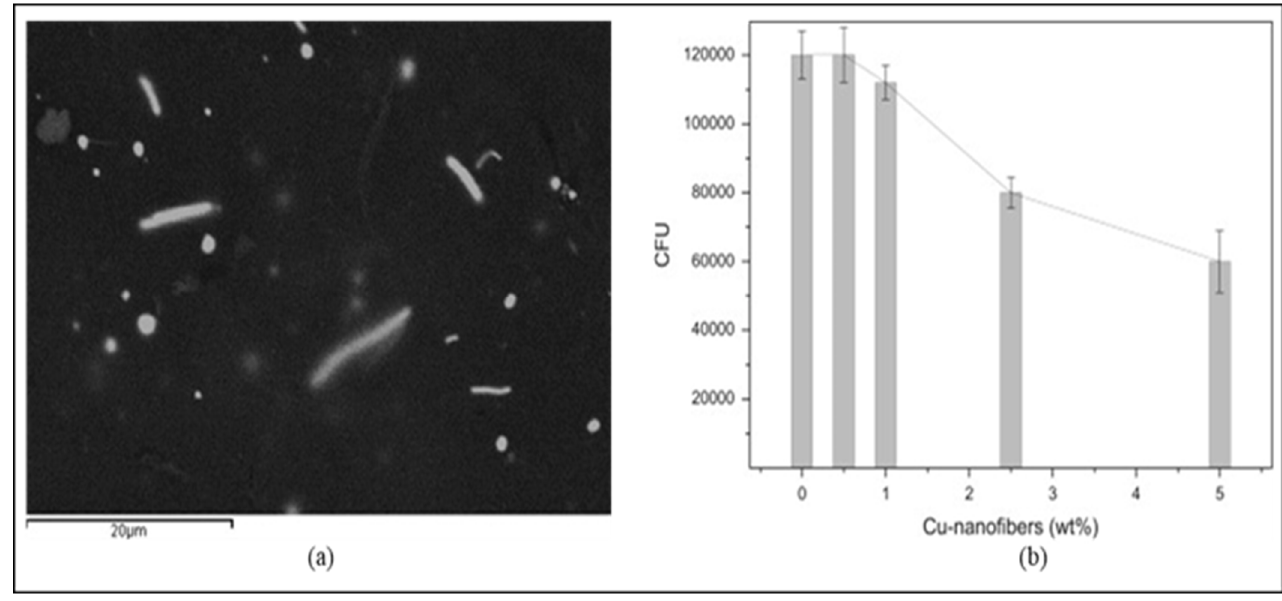
Figure 7. ( a ) SEM images of HDPE/Cu-nanofiber nanocomposites containing 2.5 wt % Cu nanofibers. ( b ) Growth of bacterial colony forming units (CFU) in nanocomposites containing different amounts of Cu nanofibers during an incubation time of 24 h. Reproduced from ref. [80] with permission from Elsevier.